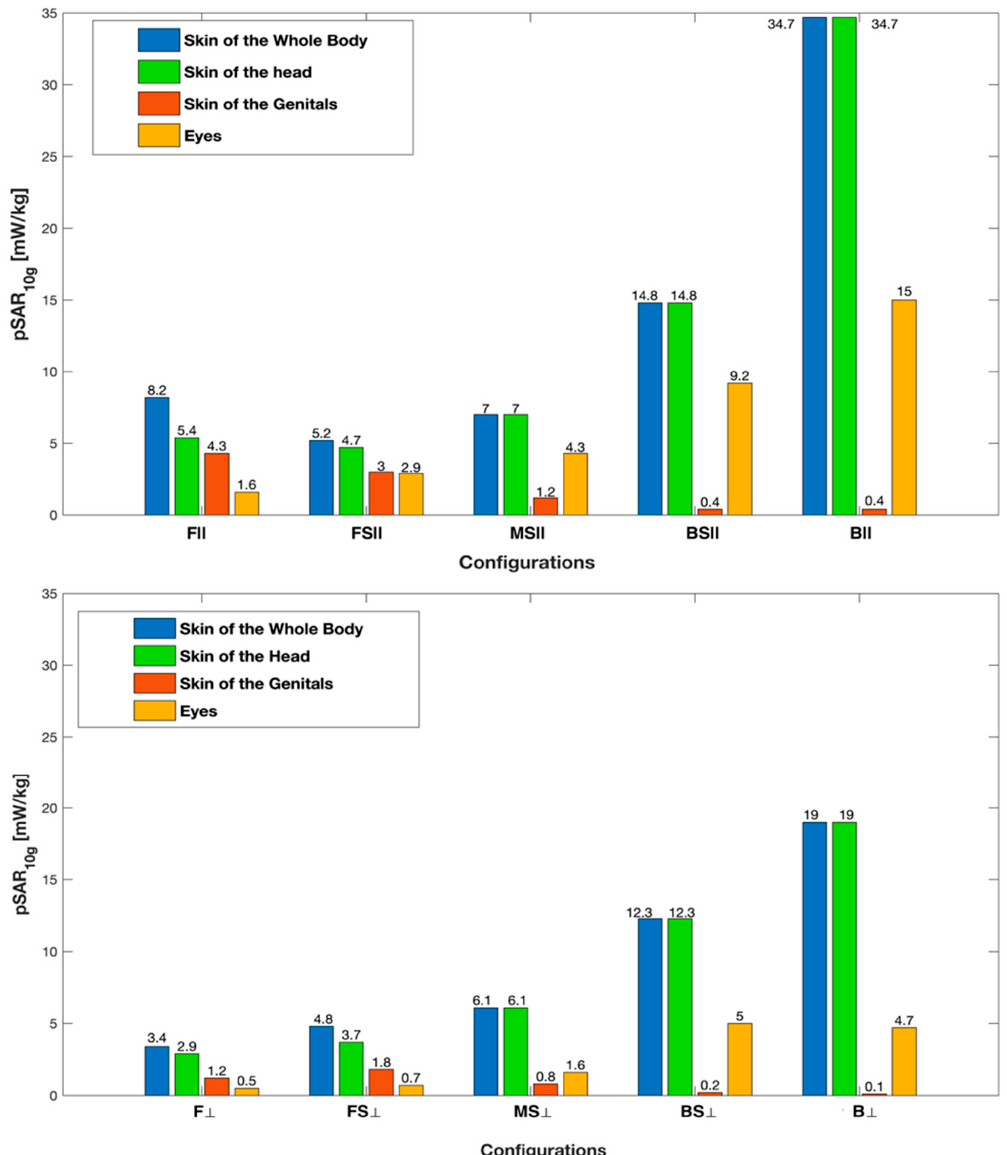
Figure 4. pSAR 10g across tissues as a function of the human model configuration in the frontal (||, top panel) and perpendicular ( ⊥ , bottom panel) orientations.